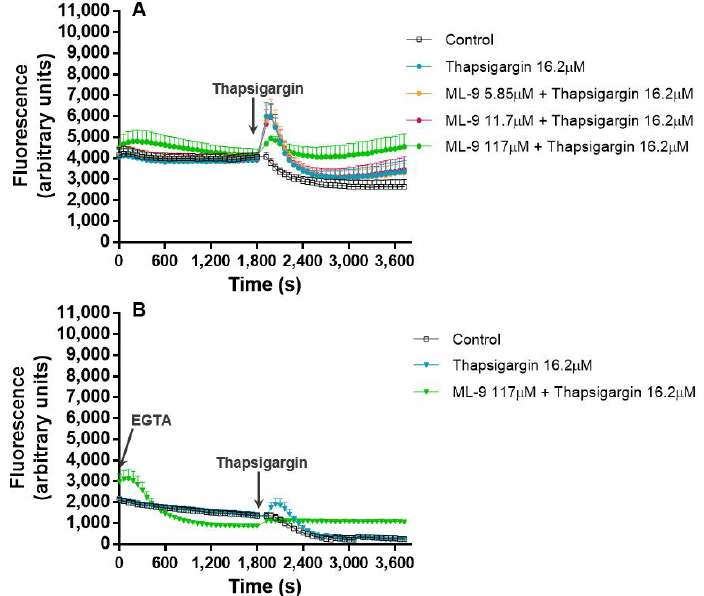
Figure 5. ML-9 and thapsigargin combined effects. ML-9 (0–117 µ M) and thapsigargin (16.2 µ